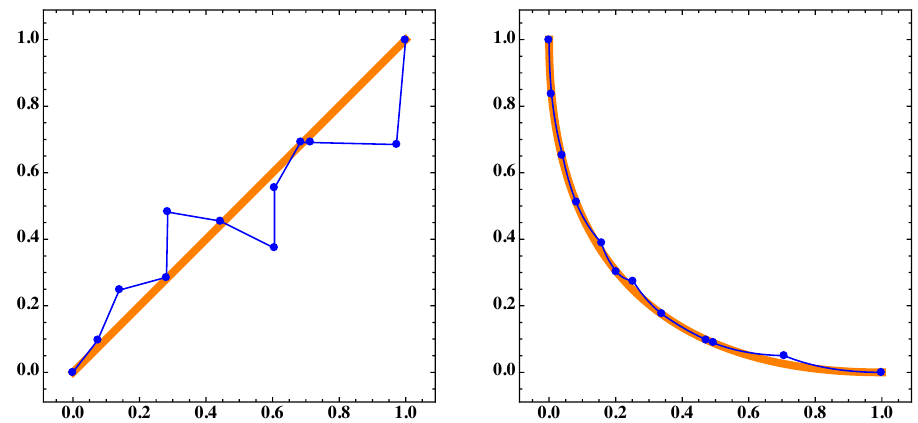
Figure 18. ( Left ) the blue dots A and the blue polygonal line are the discrete and continuous approximations, respectively, for the Pareto set and the orange thick segment is for the 410th generation of the NSGA-II algorithm of MOP (Equation (16)) for n = 2. ( Right ) corresponding sets F ( A ) and F ( B ) of the Pareto front for γ = 2.